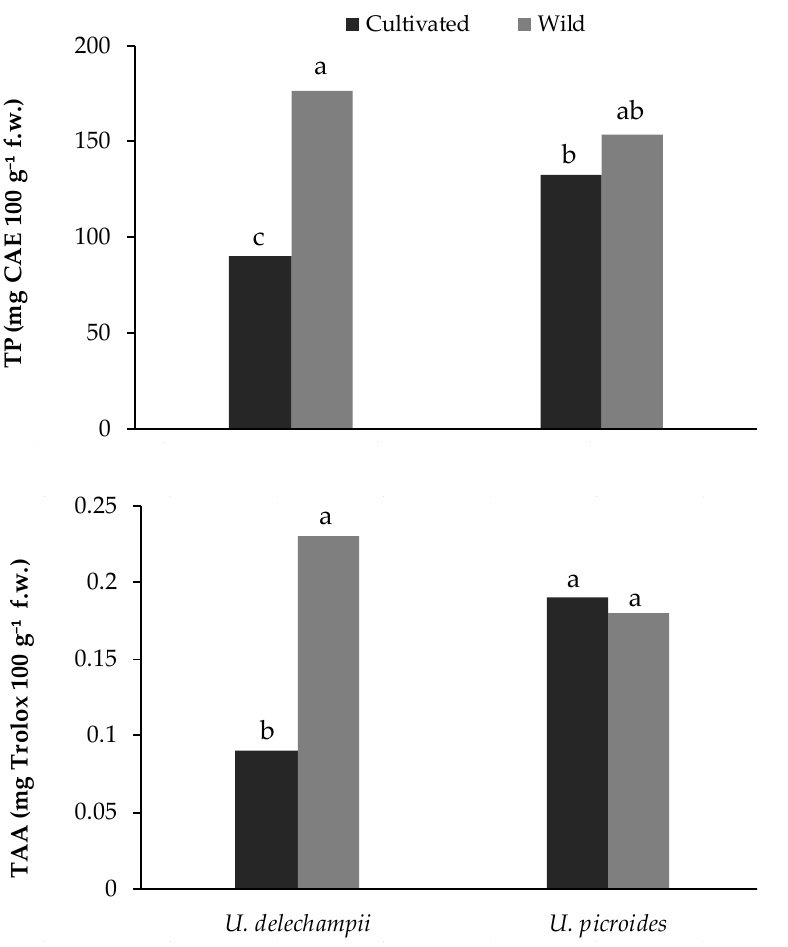
Figure 6. Total phenols (TP) and total antioxidant activity (TAA) of smooth golden fleece ( U. delechampii ) and prickly golden fleece ( U. picroides ) grown in a floating system (cultivated) and gathered in grasslands (wild). TP and TAA were considered significantly different at p ≤ 0.05 and p ≤ 0.01, respectively. The same letters indicate mean values not significantly different ( p = 0.05). CAE = caffeic acid equivalent. Trolox = 6-hydroxy-2,5,7,8-tetramethylchromane-2-carboxylic